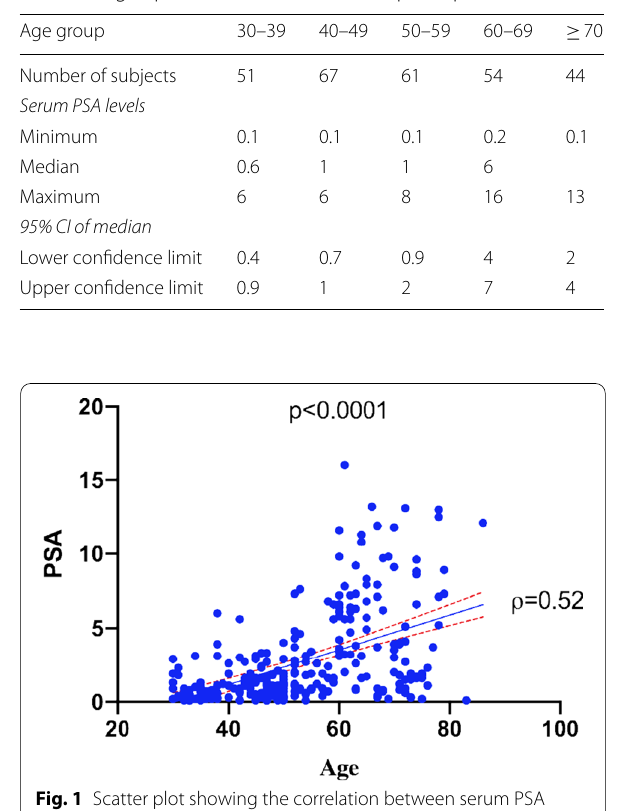
Table 3 Prostate volumes in 10-year age intervals